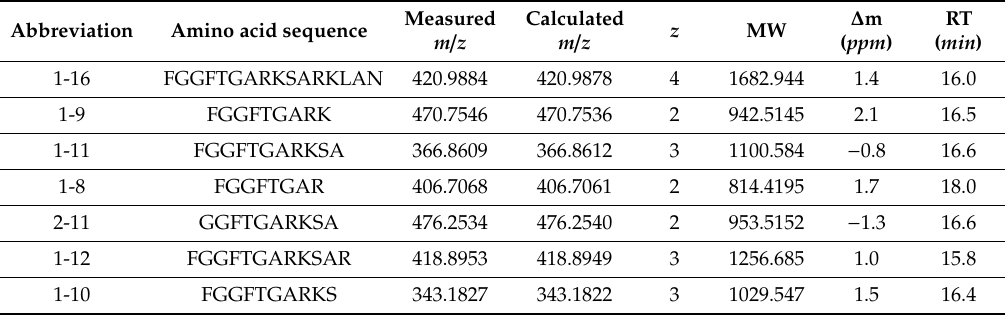
Table 1. List of all the identified IDE-promoted OFQ / N hydrolytic peptides and their LC-MS